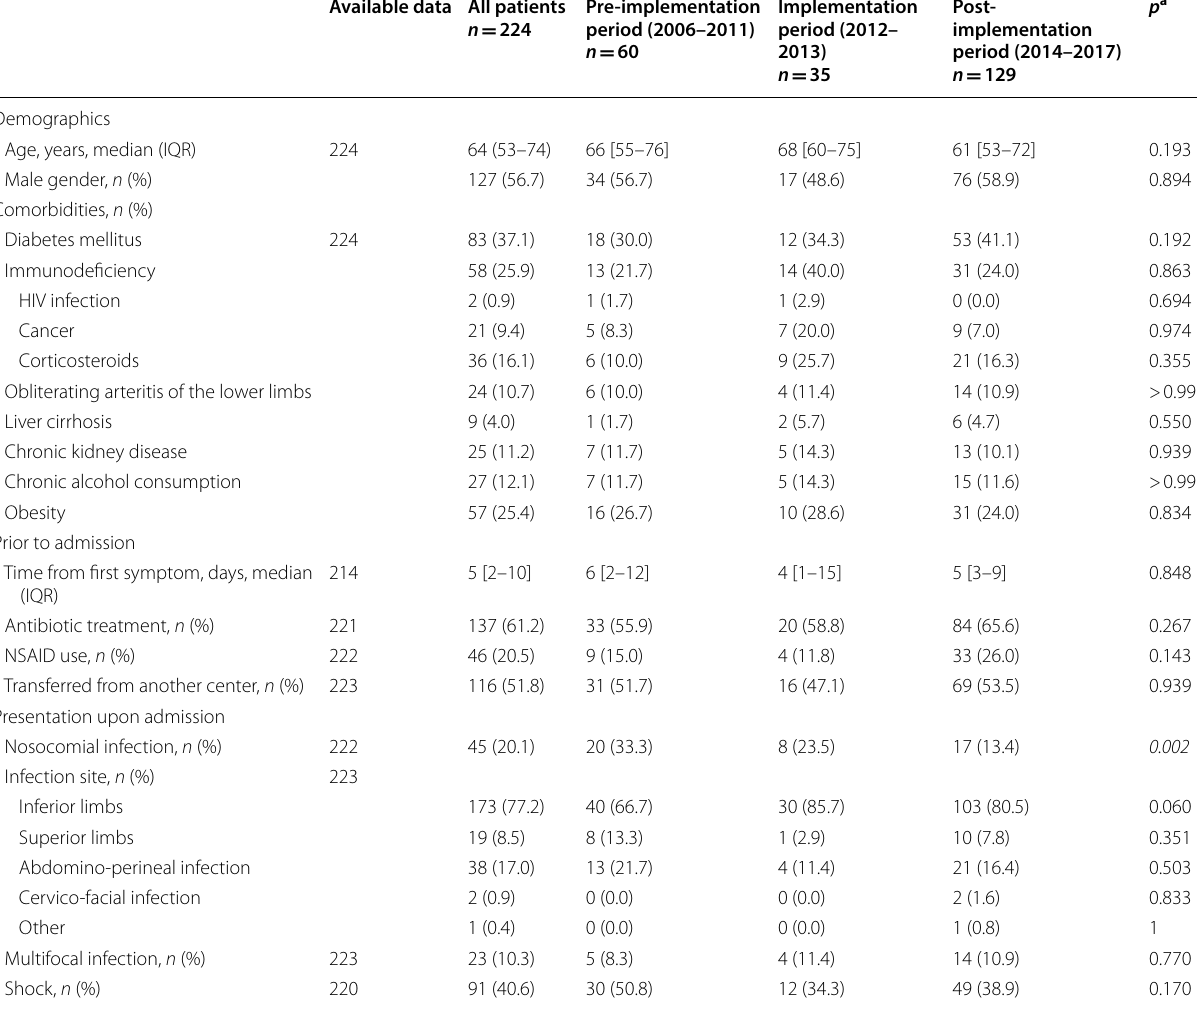
Table 1 Demographics, comorbidities and clinical features upon admission of patients with necrotizing skin and soft tissue infections before ( n 60), during ( n 35) and after ( n 129) the implementation of a dedicated multimodal = = = and multidisciplinary